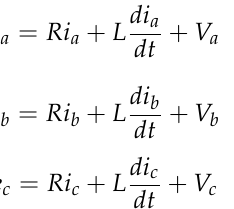
Figure 10. Configuration of the AFE rectifier system in the testbed.